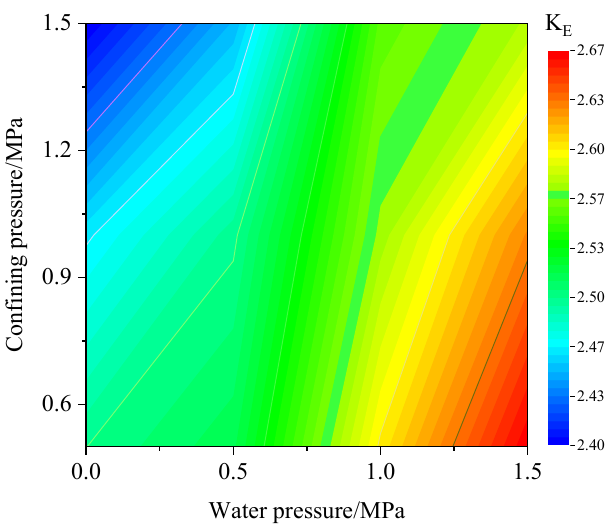
Figure 18. Change in K E under different water and confining pressures.